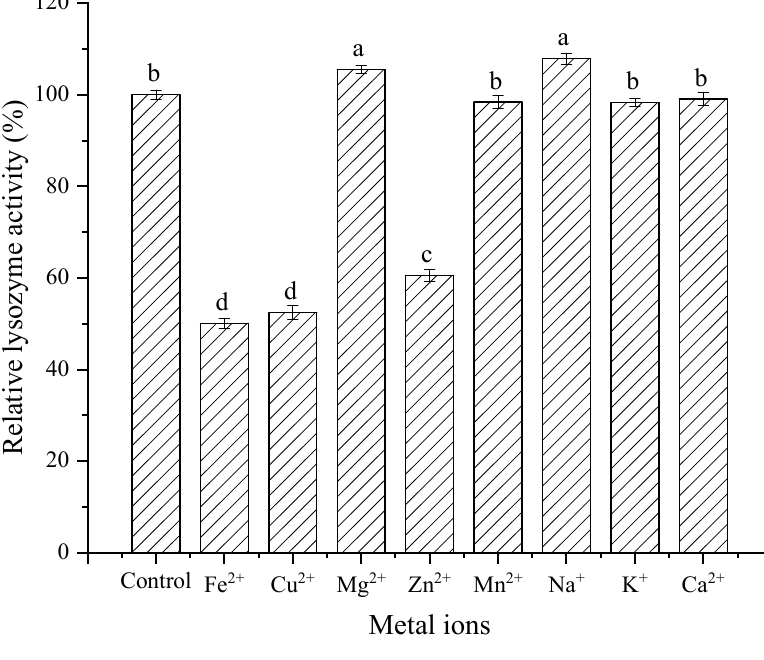
Figure 11. Effect of metal ions on activity of lysozyme from SDEW.